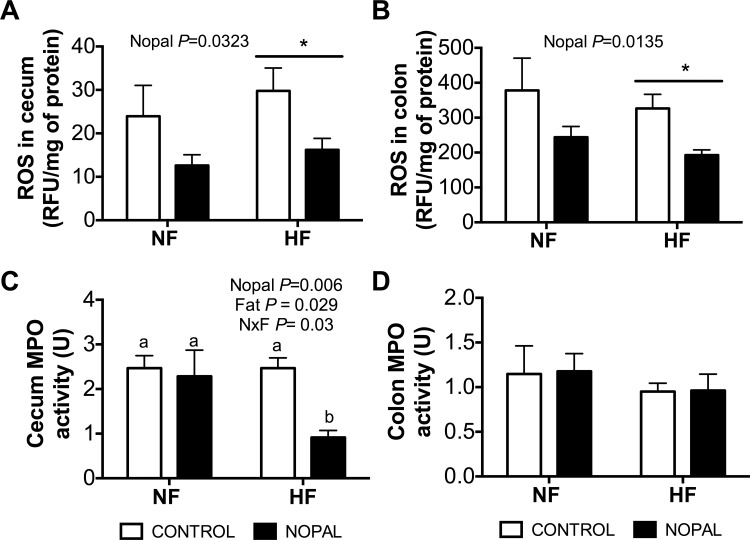
The addition of nopal to the NF and HF diets reduces ROS in the cecum and colon irrespective of the amount of fat.ROS in A) cecum and B) colon. MPO activity of C) cecum and D) colon. Values are presented as mean ± SEM (n = 5–14 per group). Significance was set at p < 0.05.